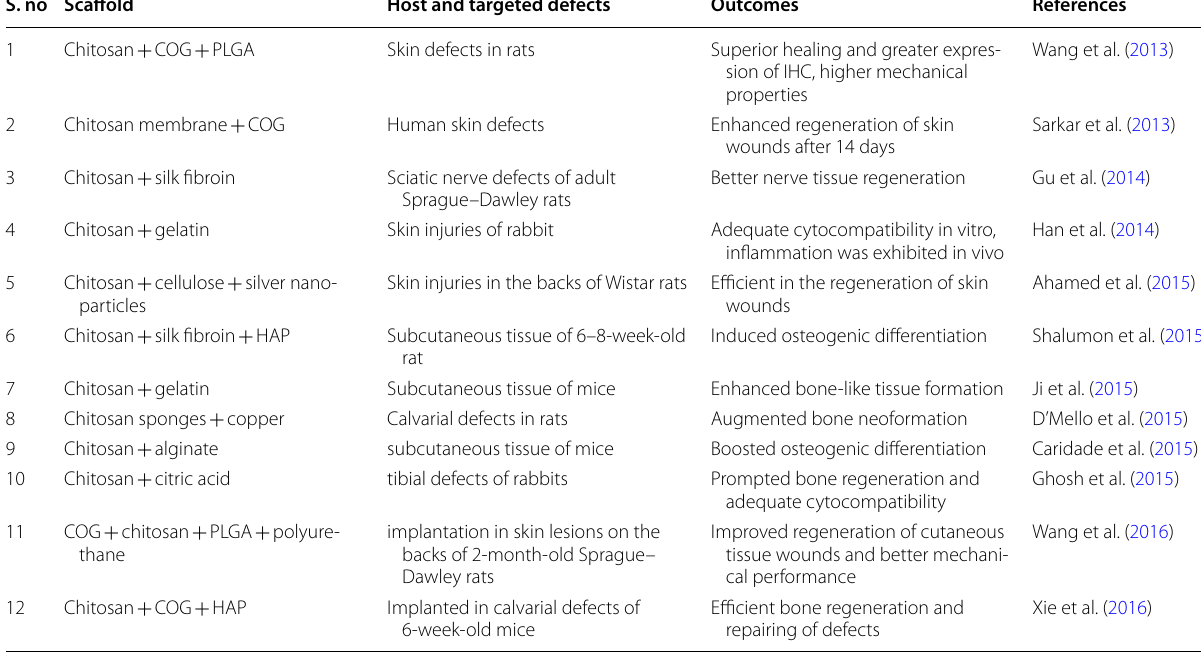
Table 5 Studies related to chitosan blends and their application S. no